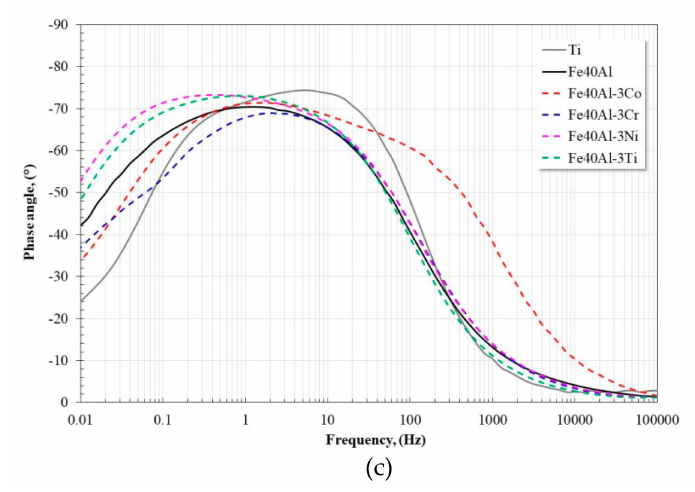
Figure 5. Nyquist ( a ) and Bode ( b , c ) plots for alloys exposed in artificial saliva at 37 ◦ C after 24